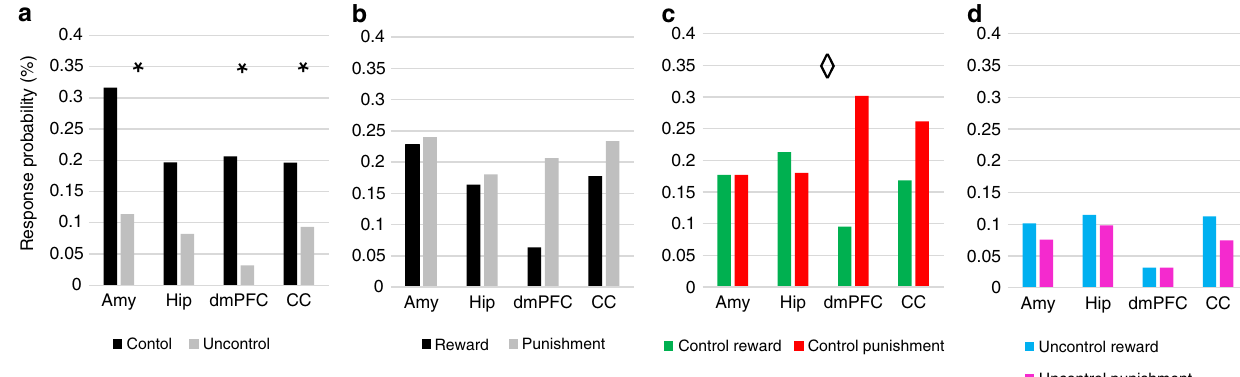
Fig. 3 Neurons ’ response probability in different regions and outcome conditions. Percent of neurons per region presenting a signi fi cant change in fi ring rate (FR) between 200 and 800 ms in response to: a Controlled (black) or Uncontrolled (gray) outcomes (across valence); N = 79, 61, 63, and 107 independently sampled neurons for the amygdala, hippocampus, dmPFC, and CC, respectively. A two-sided McNemar ’ s exact test found effects at p = 0.088, p = 0.011, and p = 0.049 for the amygdala, dmPFC, and CC, respectively, FDR corrected. Asterisks represent signi fi cant at p < 0.05. b Reward (black) or Punishment (gray) outcomes (across controllability); N is similar to ( a ). c Controlled rewards or punishments ( N = 93 independenty sampled neurons from four or two brain regions, p = 0.065 and p = 0.014 using χ 2 test, respectively). Diamond denotes signi fi cant valence preference between MTL and mPFC at p < 0.05. d Uncontrolled rewards or punishments ( N = 39 independenty sampled neurons from four or two brain regions, p = 0.97 and p = 0.99 using χ 2 test, respectively). Amy amygdala, Hip hippocampus, dmPFC dorsomedial prefrontal cortex, CC cingulate